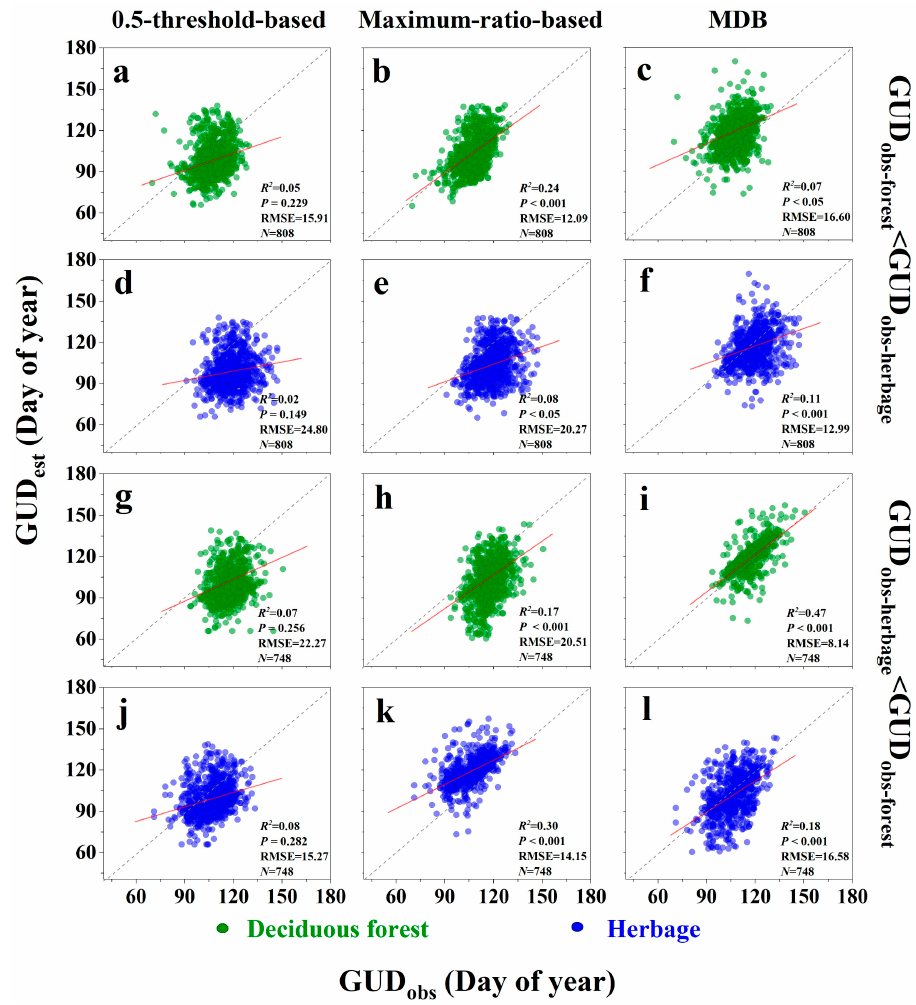
Figure 7. Comparisons between annual observed green-up dates (GUD obs ) of deciduous forest (green) and herbages (blue) and estimated green-up dates (GUD est ) of three methods (0.5-threshold- based method, Maximum-ratio-based method, and Maximum-derivative-based (MDB) method) for forest-herbage-mixed (FHM) sites with GUD obs-forest < GUD obs-herbage ( a – f ) and with GUD obs-herbage < GUD obs-forest ( g – l ). The gray dashed line represents the 1:1 line, and the red lines are the regression lines. The root mean square error (RMSE) was also used to evaluate the predictive performance.